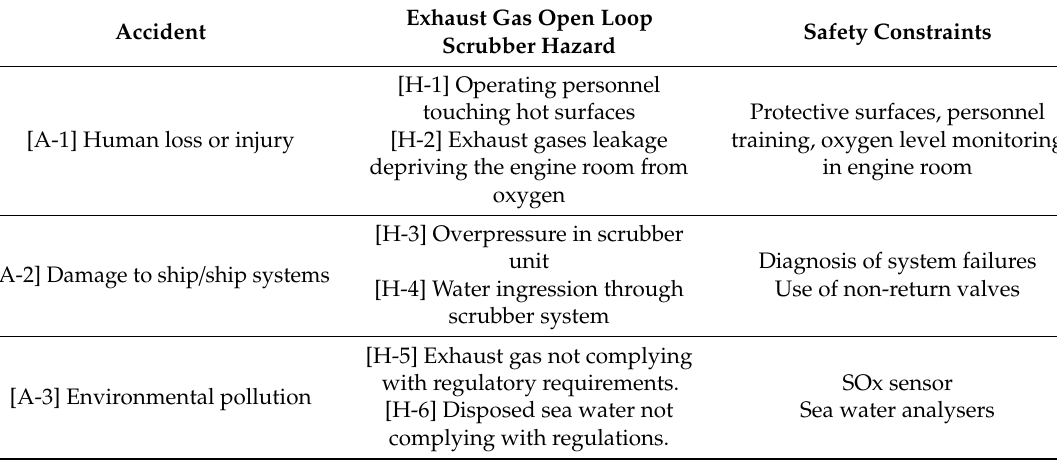
Table 5. Accidents in the scrubber